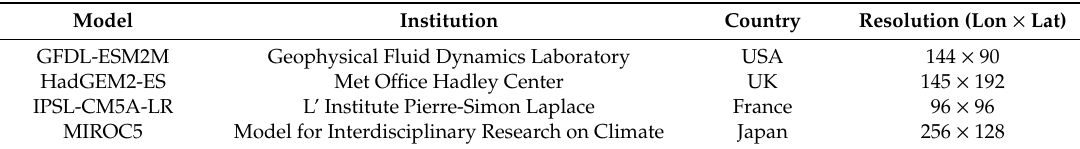
Table 2. List of the four ISI-MIP 2b models used in the analysis.